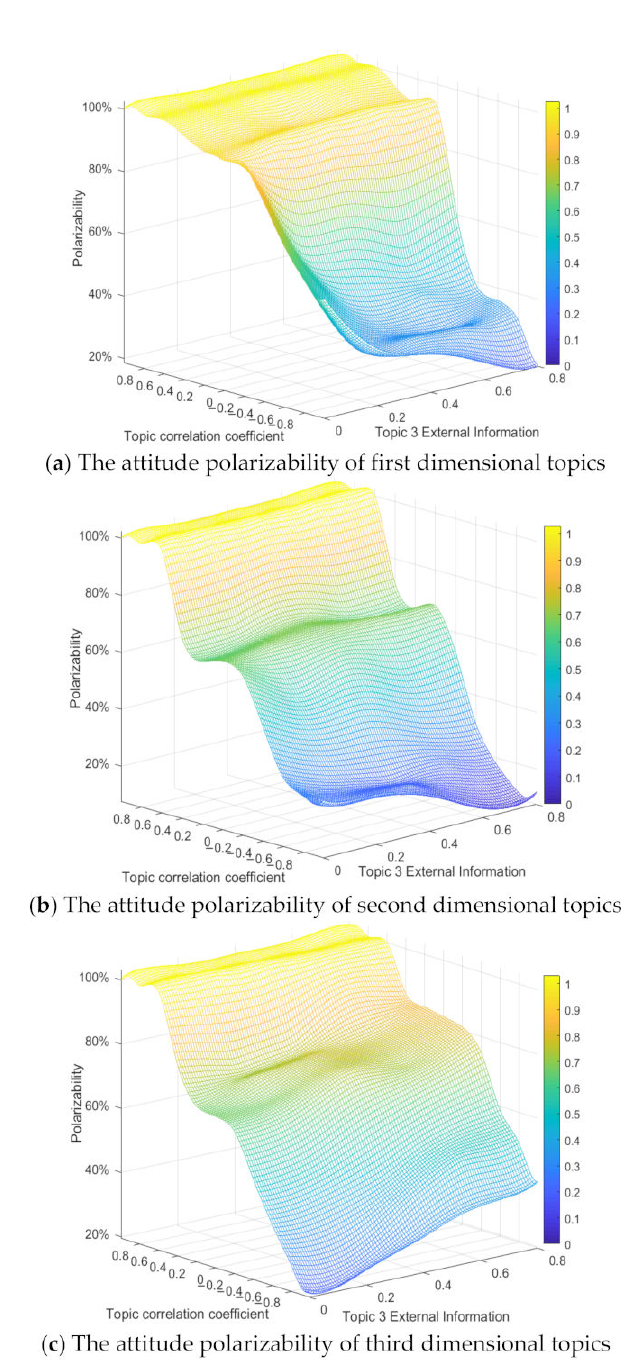
Figure 21. The relationship between external information intensity, topic correlation coefficient and attitude